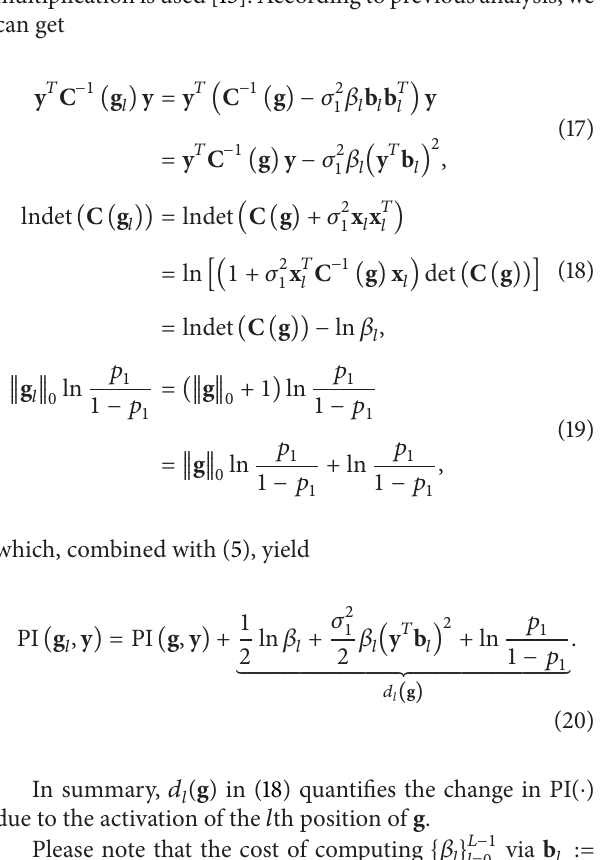
where b 𝑙 := C − 1 ( g ) x 𝑙 and 𝛽 𝑙 := (1 + 𝜎 2 1 x 𝑇 𝑙 b 𝑙 )